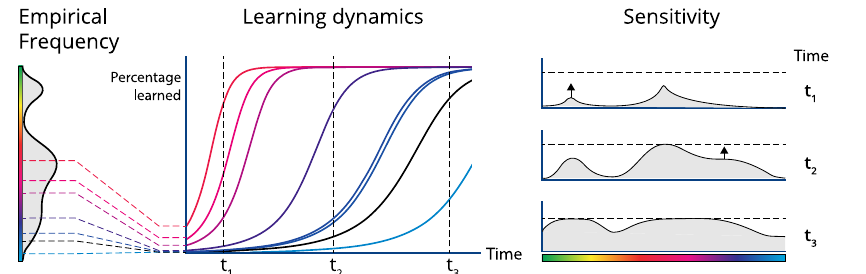
Fig. 4 | Schematic of how the learning dynamics of linear networks causes a correspondence between network sensitivity and input statistics. The learning problem is broken into components, each of which learns at a speci fi c rate. The frequency or variance of a feature of the input data (e.g. the color red) in part